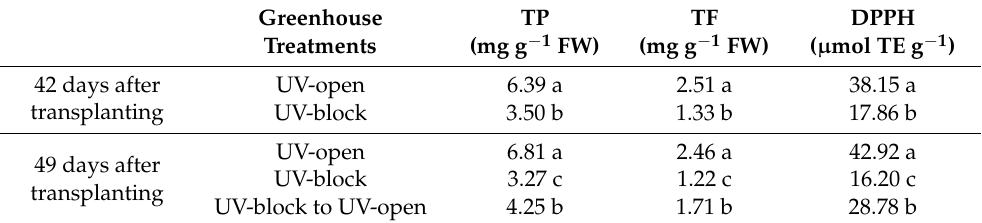
Table 4. Effects of greenhouse cover transparency in UV-A radiation on total phenols (TP), total flavonoids (TF), and antioxidant capacity (DPPH) of red lettuce (Redino Lollo rosso) 42 and 49 days after